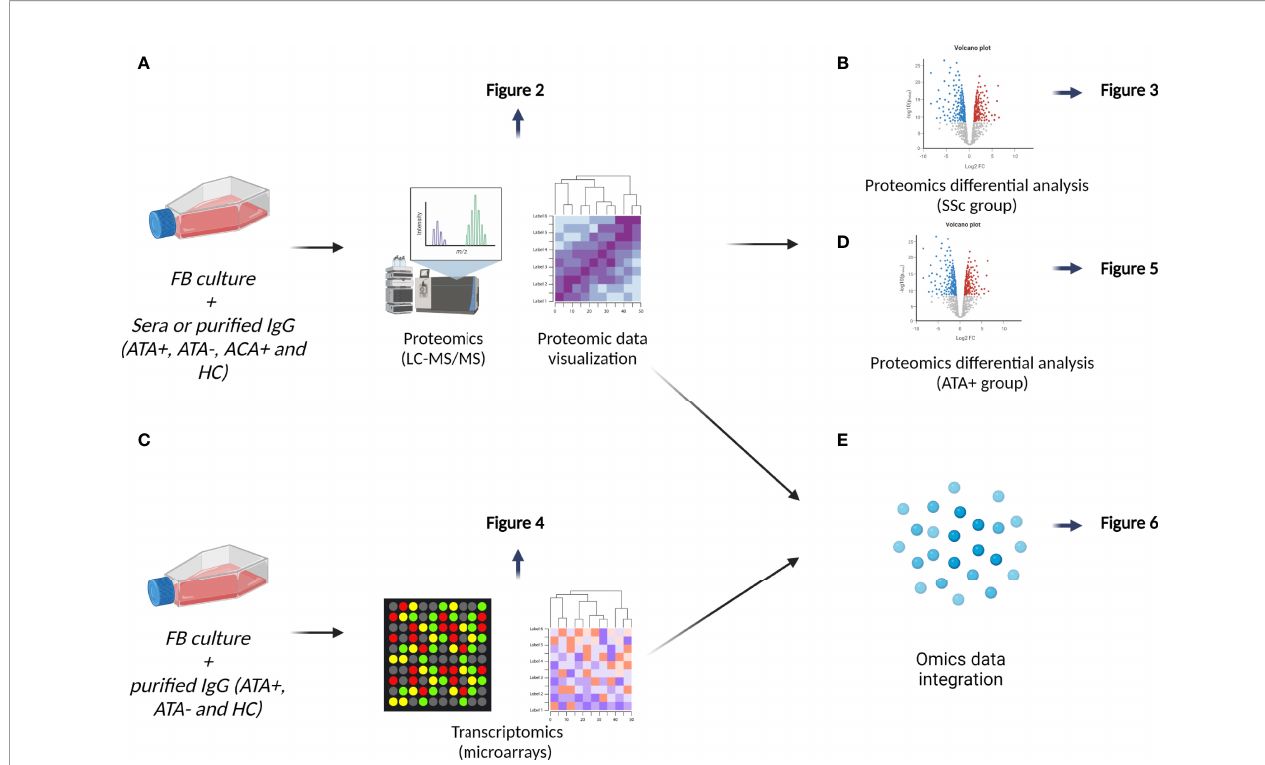
FIGURE 1 | Data analysis work fl ow. (A) We fi rst performed principal component analysis on proteomics data and then hierarchical clustering results were visualized on heatmap, see Figure 2 . (B) We explored effect of SSc sera and SSc IgG (all serotypes) by conducting differential analysis, see in Figure 3 . (C) Transcriptomic analyses of FB cultured in the presence of IgG from dcSSc (ATA+ and ATA − ) and HC were conducted by proteomics results, see in Figure 4 . (D) We then focused on the singular group “ puri fi ed IgG from ATA+ patients ” in proteomics, see in Figure 5 . (E) Finally, we performed a second way of multi-omics integration from whole proteomics and transcriptomics data, see in Figure 6